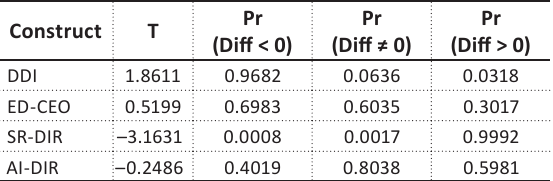
Table 5. Mardia multivariate normality test Multivariate normality test